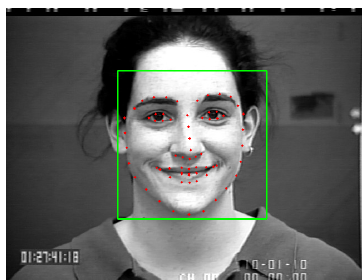
Figure 6. Detected face from the CK+ database using the Dlib library.